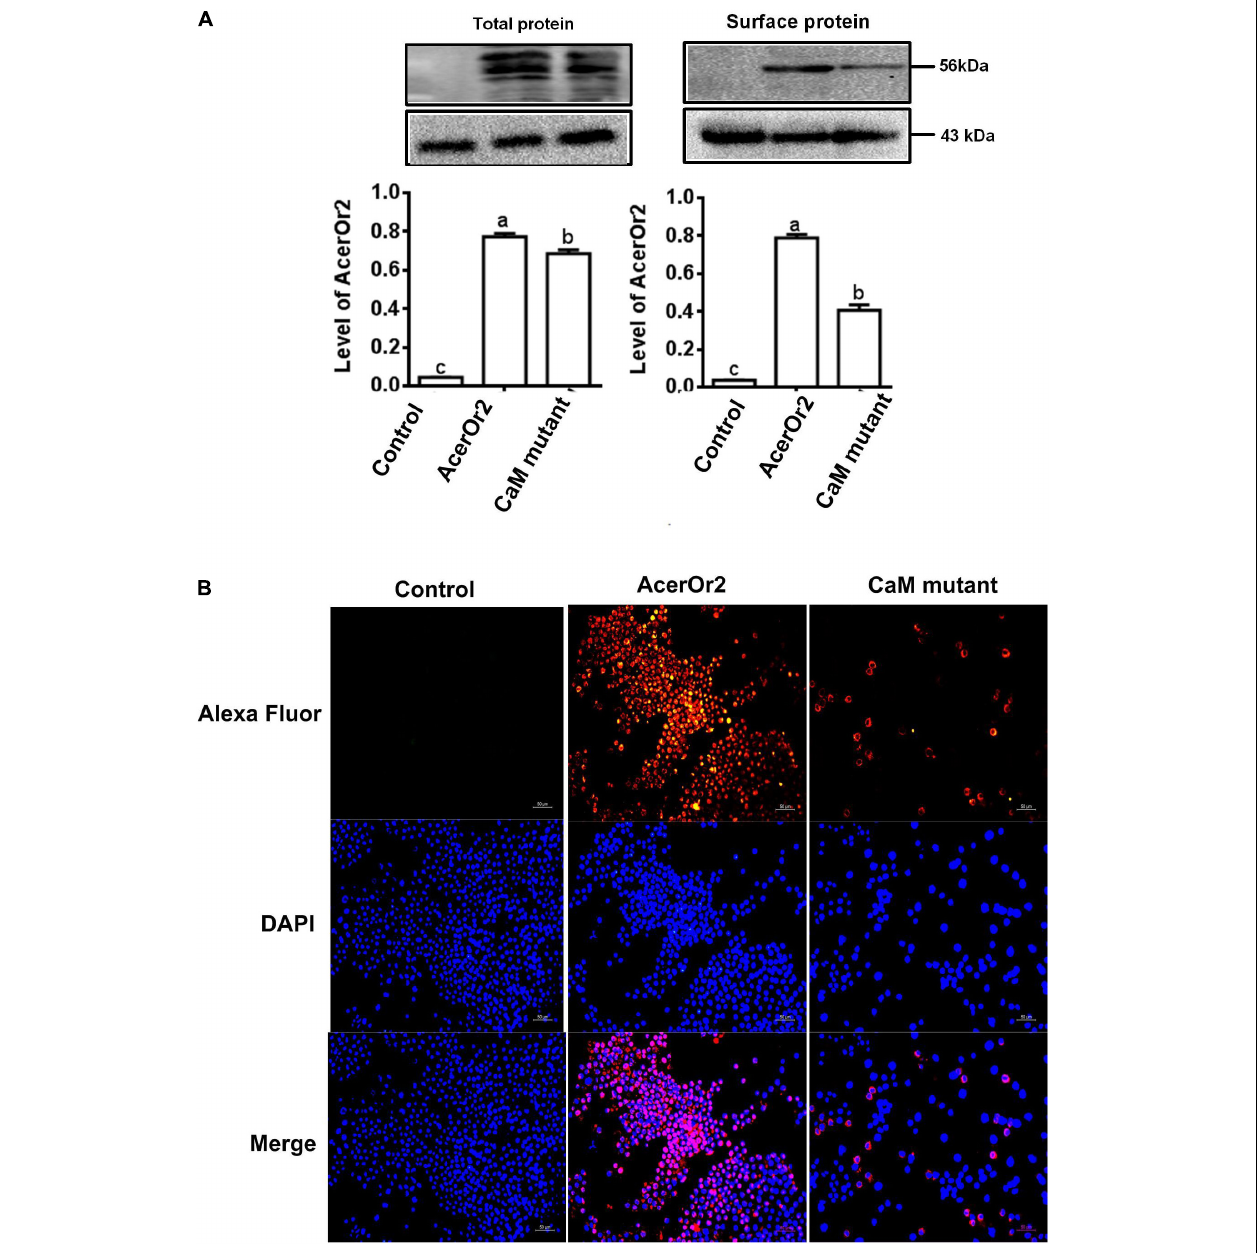
FIGURE 2 | Effects of K331N mutant transporters in AcerOr2 protein expression, cellular distribution. (A) Comparison of the expression and cellular distribution of AcerOr2 and its mutants expressed in Sf9 cells. Samples of total protein and the cell-surface protein were analyzed by Western blotting by anti-AcerOr2, the molecular weights of AcerOr2 and β -actin are 56 and 43 kDa, and expression of AcerOr2 relative to that of β -actin. Bars represent the mean ± SEM from three independent experiments, and data were analyzed using one-way ANOVA. Different letters indicate the significant difference among groups ( P < 0.05). (B) Immunofluorescence and membrane staining of AcerOr2 and AcerOr2 CaM (K331N) mutants expressed in Sf9 cells. Scale bar = 50 µ m.